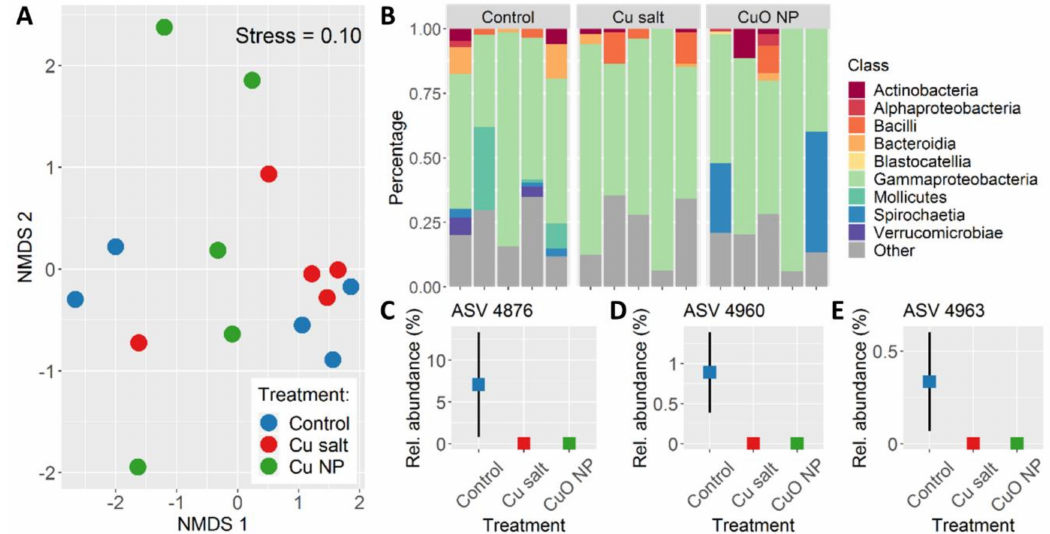
Figure 3. Bacterial community composition and structure of earthworm gut samples at the end of the pre-treatment exposure (i.e., ‘pre-treatment day 28’). ( A ) Plot of non-metric dimensional scaling (NMDS) showing ordination of samples at amplicon sequence variant (ASV) level. ( B ) Relative abundance of dominant ASV at class level per sample. All ASVs with a relative abundance < 1% of the total community are grouped under “Other”. Mean relative abundance ( ± se) per treatment as percentage of total community of ( C ) ‘ Candidatus Lumbricincola’ (ASV 4876), ( D ) Luteolibacter pohnpeiensis (ASV 4960), and ( E ) Luetolibacter (ASV